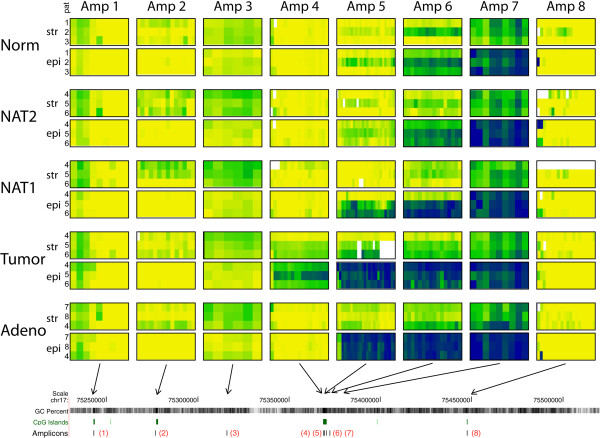
Bisulfite DNA sequencing results for SEPT9 amplicons. Each column displays results from one amplicon and each row displays results for one cell type. Within each of the rectangular boxes, the columns correspond to single CpGs and the three rows correspond to three patients. As all amplicons are drawn to the same scale the location of the amplicons is illustrated at the bottom with arrows pointing to the genomic map (compare to Figure 1). Color coding: yellow = unmethylated (0%), green = partially methylated (50%), blue = fully methylated (100%), and lighter or darker green/blue colors provide methylation levels below or above 50%. White areas = no sequencing data available. Abbreviations: str = stromal cells, epi = epithelial cells, Norm = normal colon tissue, NAT1 = normal adjacent tissue (1 cm away from tumor), NAT2 = normal adjacent tissue (> 10 cm from tumor), Adeno = adenoma tissue, pat = patient no.: only the last number of the patient ID in Additional file 1: Table S1 is shown here.